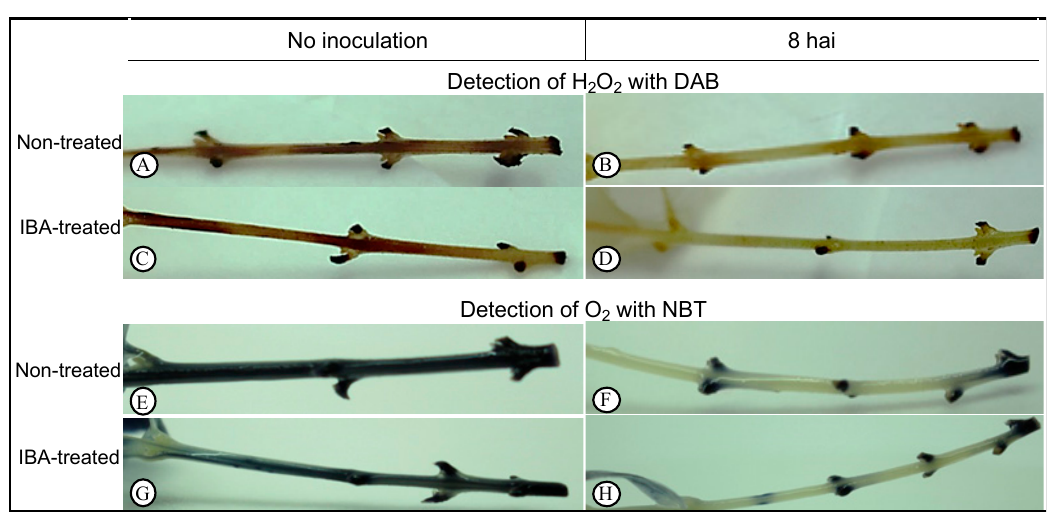
Figure 2. Detection of hydrogen peroxide (H 2 O 2 ) with 3,3 ′ -diaminobenzidine (DAB) ( A – D ) and superoxide anion (O 2 ) with nitroblue tetrazolium (NBT) ( E – H ). Histochemical detection analyses were performed at 0 h after inoculation (hai) (no inoculation) and at 8 hai in the culture medium.